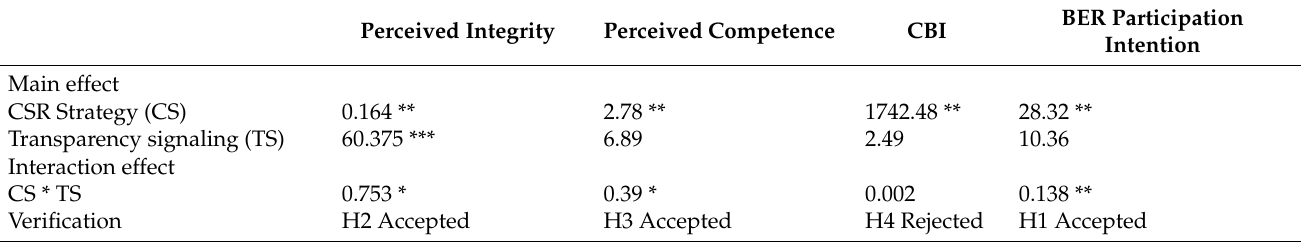
Table 5. Analysis of covariance results for dependent variables